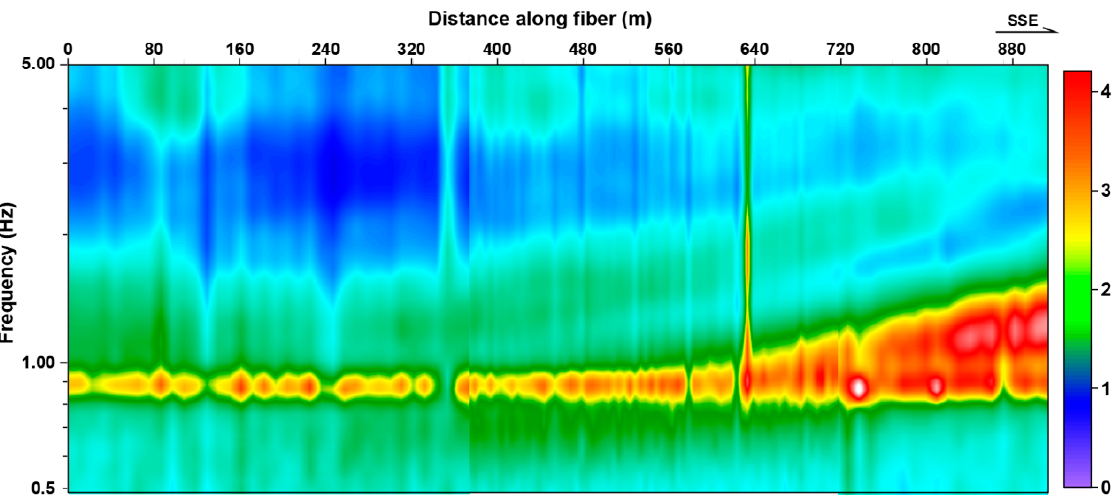
Figure 4. H/V spectral ratio curves calculated by Geopsy based on the three-component seismometer data.